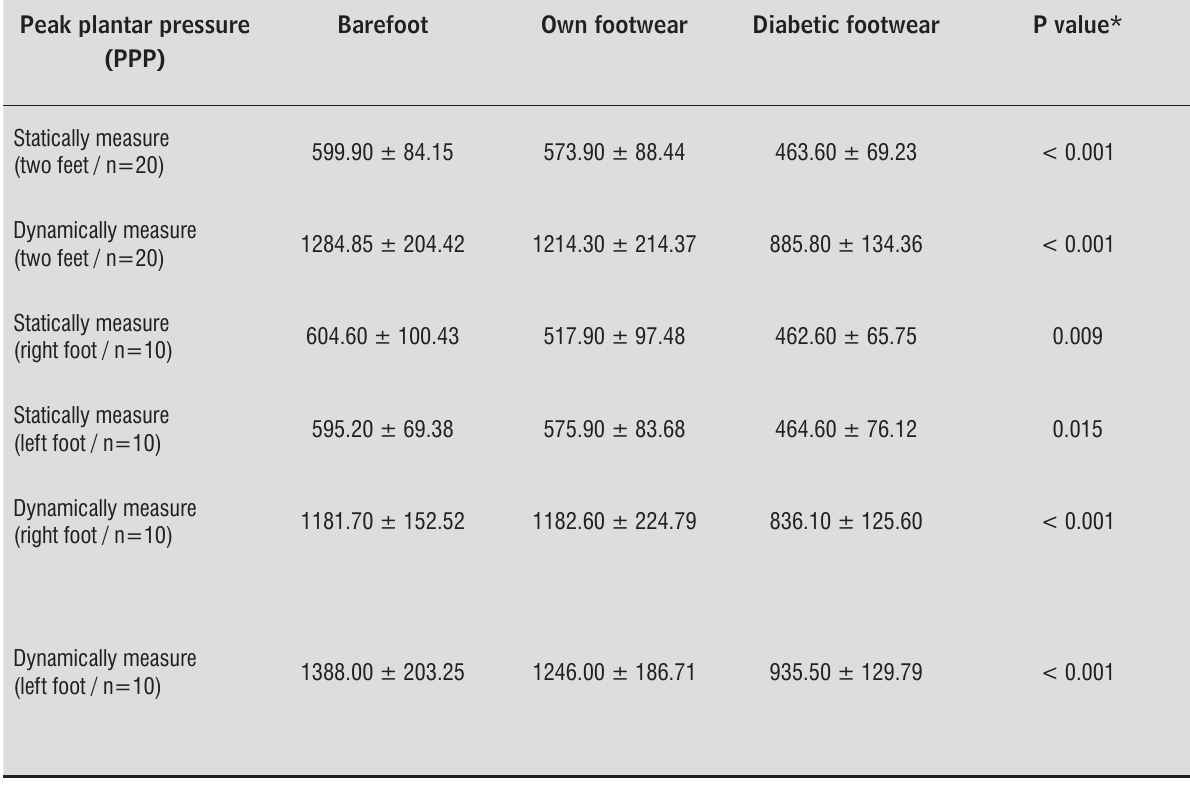
Table 1 - Comparison of peak plantar pressure, barefoot, with the patient own footwear Peak plantar